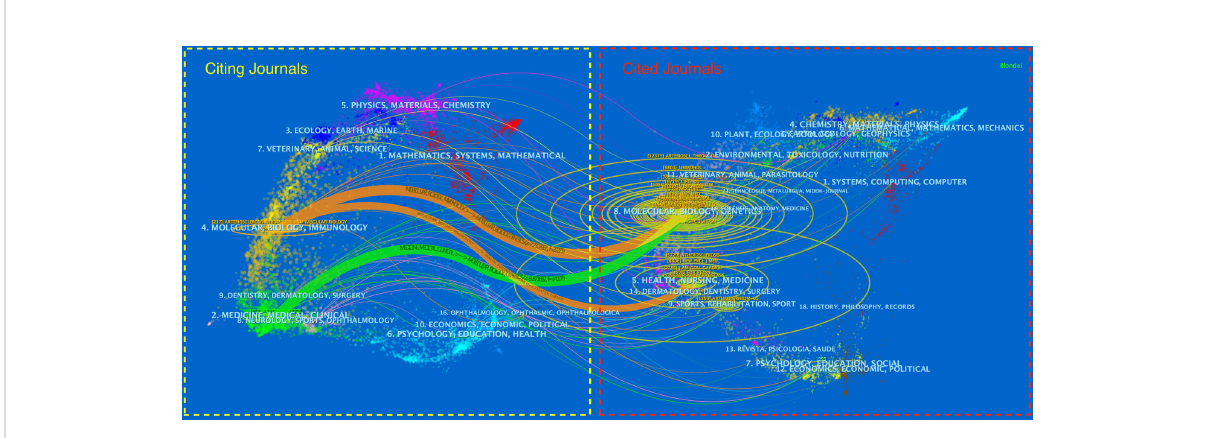
FIGURE 5 The dual-map overlay of journals in T cell and AS.